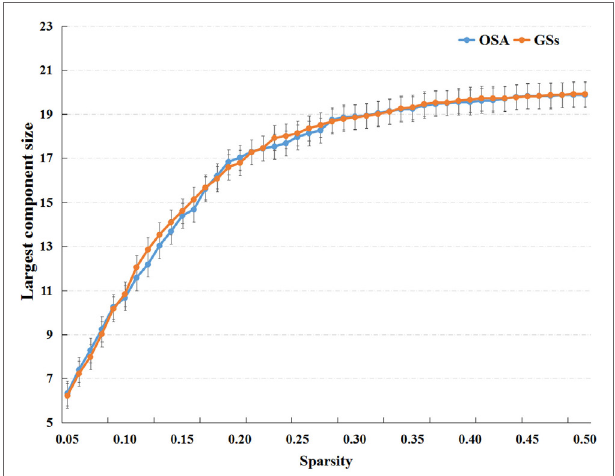
FigUre 1 | The largest component sizes of individual networks both of the patients with obstructive sleep apnea (OSA) and good sleepers (GSs) over the sparsity range of 0.05–0.50.